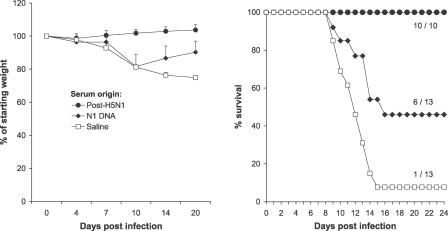
Cross-Protective Effects of huN1-Immune Serum against H5N1 InfluenzaMice were passively immunized with serum from mice that had recovered from H5N1 influenza virus infection (post-H5N1), were vaccinated twice with huN1 DNA (N1 DNA), or were vaccinated twice with saline alone. Eighteen hours after passive immunization, recipient mice were challenged with 10 MLD50 of A/Vietnam/1203/04. Changes in mean weight (left graph) and survival (right graph) were monitored over 24 d. The difference in survival between recipients of serum from huN1 DNA-vaccinated and saline control mice was statistically significant (p = 0.037). Error bars represent standard deviation values. Statistical comparison is by Fisher's exact test.